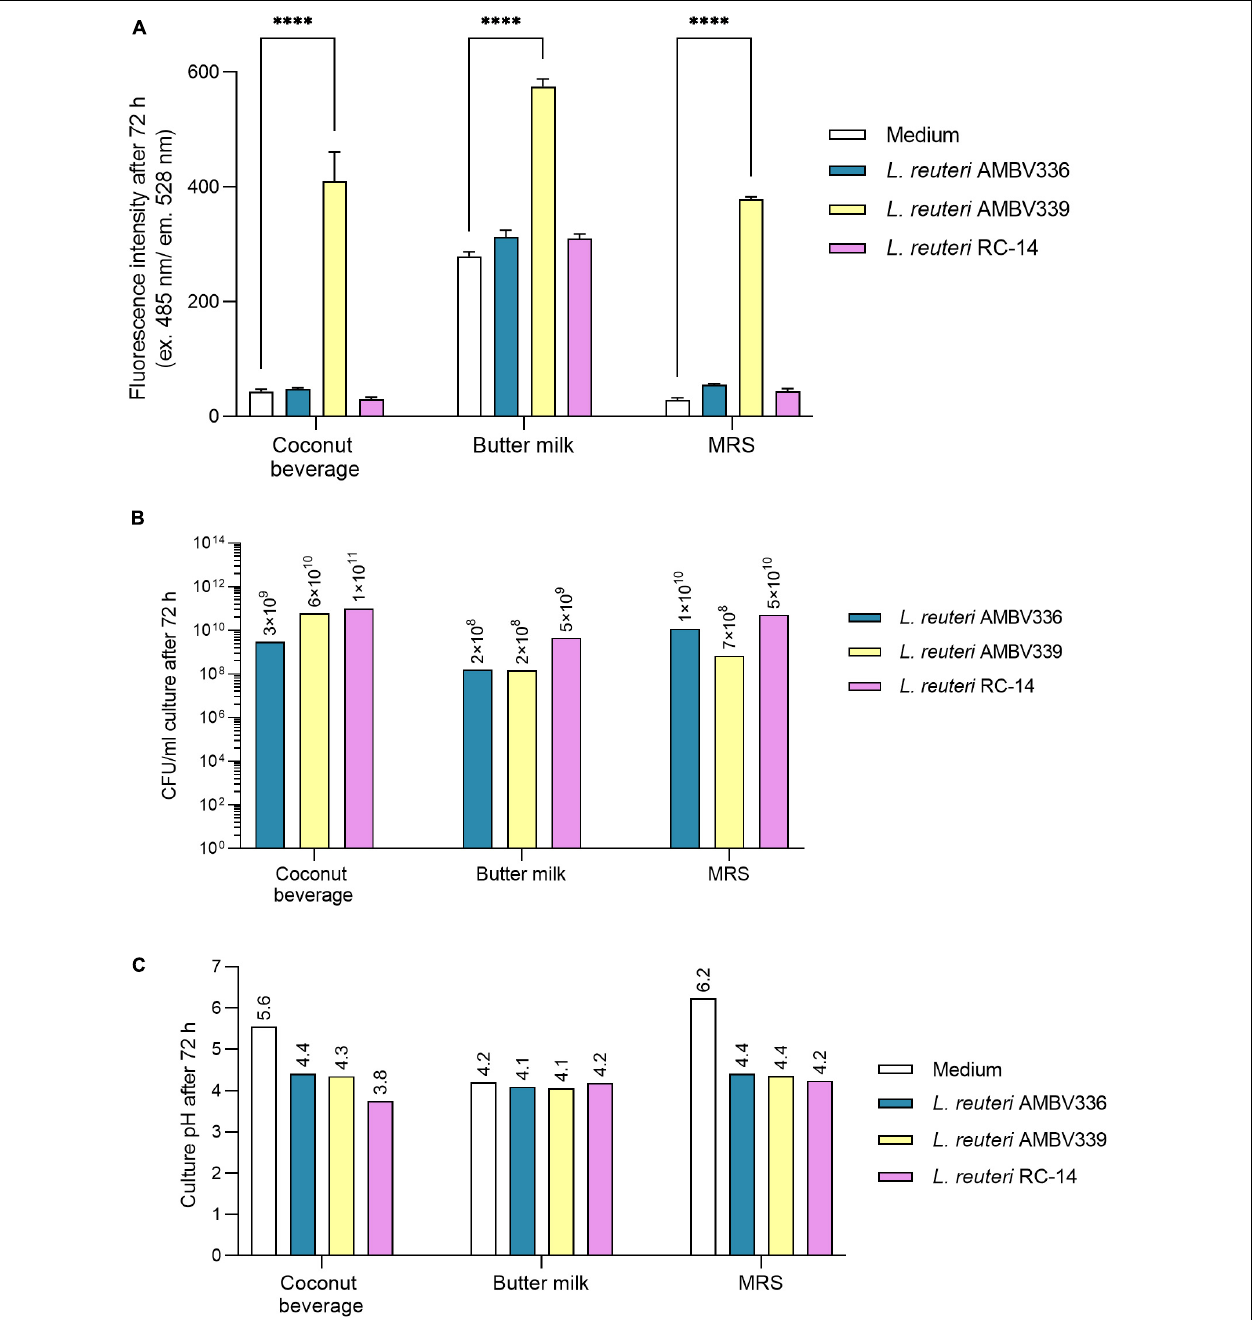
FIGURE 3 | (A) Riboflavin production, (B) biomass generation, and (C) pH lowering capacity reflecting fermentation in cultures of L. reuteri AMBV339 compared to L. reuteri AMBV336 and L. reuteri RC-14 in coconut beverage, butter milk, and MRS broth after 72 h at 37 ◦ C. Data is presented as means ± SD. ∗∗∗∗ p < 0.0001, as determined by two-way ANOVA with Tukey’s multiple comparisons